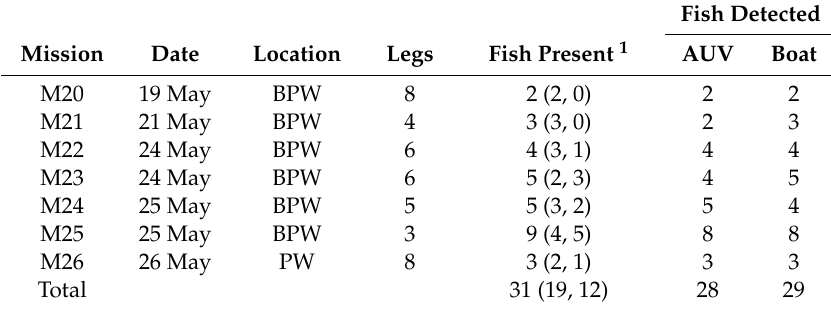
Table 2. Detections of acoustically tagged Chinook salmon located during survey missions conducted concurrently with an autonomous underwater vehicle (A) and boat (B) in marine waters of Big Port Walter (BPW) and Port Walter (PW), Alaska, during 2016. Bold upper case letters indicate detections made during the same mission that the fish were released; lower case letters indicate detections during subsequent missions.